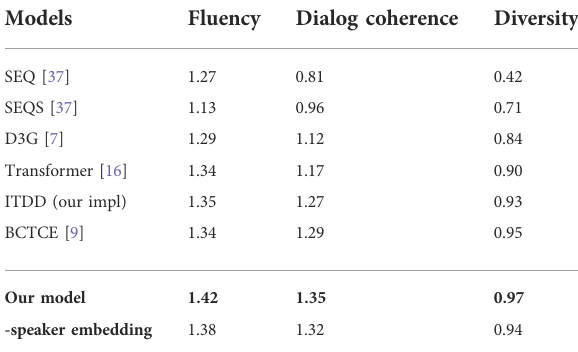
TABLE 5 Human evaluation of baselines and our proposed model. The “ -speaker embedding ” means the speaker embedding is removed from the multi-view embedding module in our